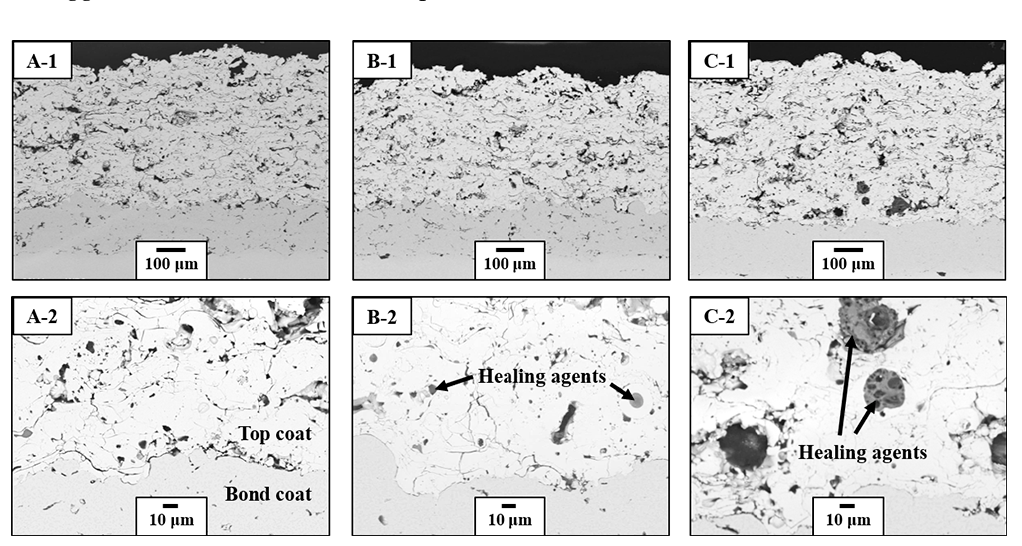
Figure 5. The particle size distribution of ( A ) normal Si, and ( B ) Si powder encapsulated by a binary system.